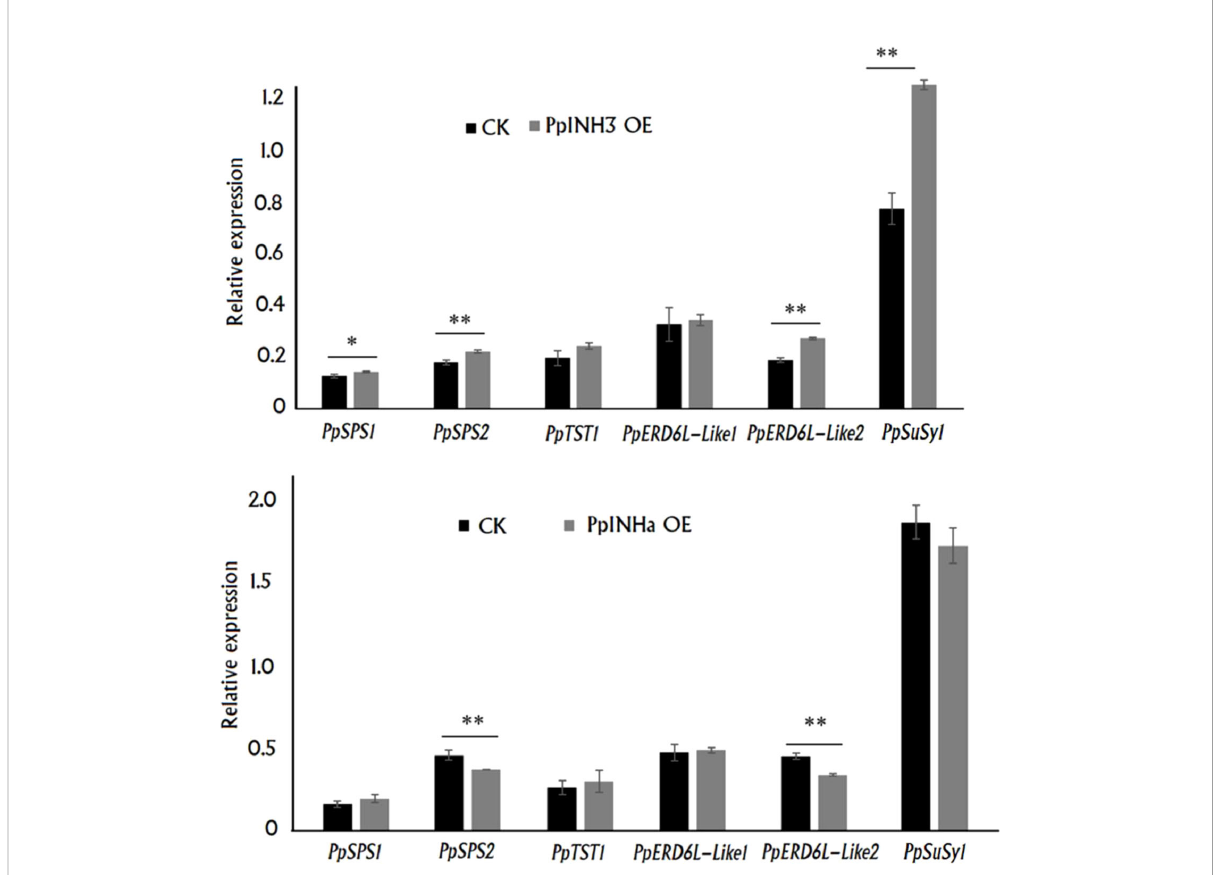
FIGURE 6 Expression of sugar accumulation-related genes in the fl eshy tissue surrounding the sites in fi ltrated with PpINH3, PpINHa or the empty vector pSAK277. ** and * indicate statistical signi fi cance at P < 0.01 and P < 0.05, respectively, based on Student ’ s